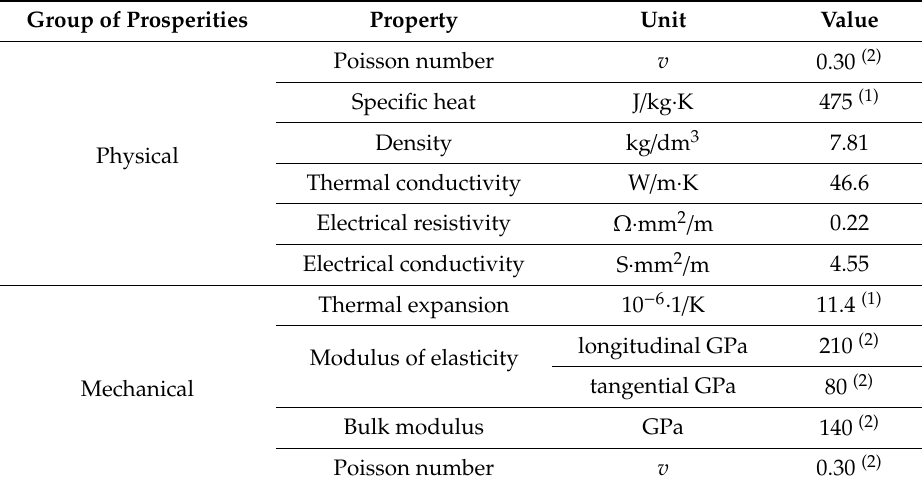
Table 1. Selected physical and mechanical properties of 100Cr6